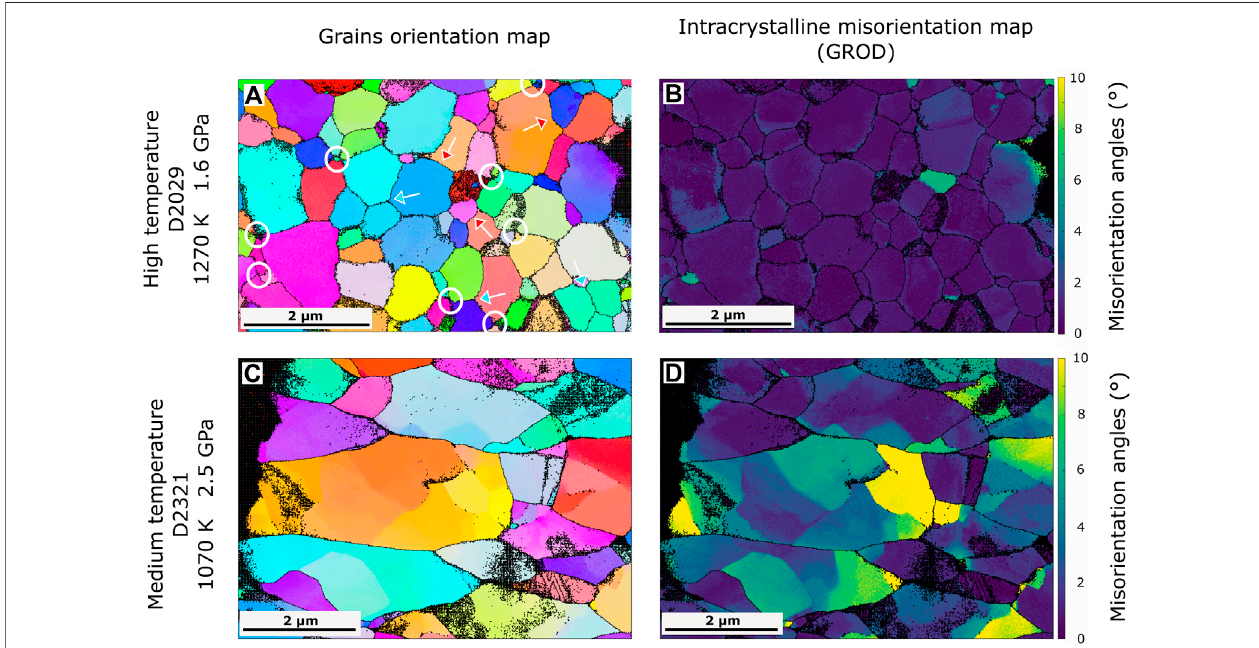
FIGURE 10 | Samples features at the TEM scale. ASTAR maps for high (A,B) and moderate (C,D) temperature samples, showing the orientations of the grains (A,C) and the intracrystalline misorientation (B,D) . Orientation maps are colored according to grain orientation relative to the compression direction (see inset in Figure 8 ). Intracrystalline misorientation is represented by GROD maps showing the internal deformation in each grain relative to the mean orientation of the grain. Corresponding local misorientation gradient maps (KAM maps showing the internal deformation gradient in each grain), are shown in Figure 11 . In the